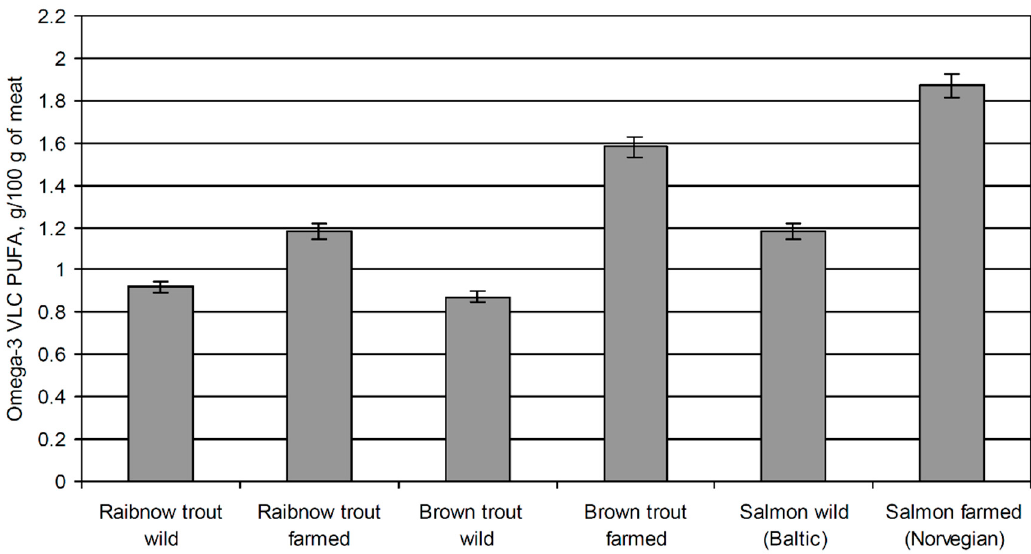
Figure 2. Omega-3 VLC PUFA content in salmonid fish fillets; g/100 g of raw meat. Values are expressed as mean ± standard deviation (SD) ( n = 3).